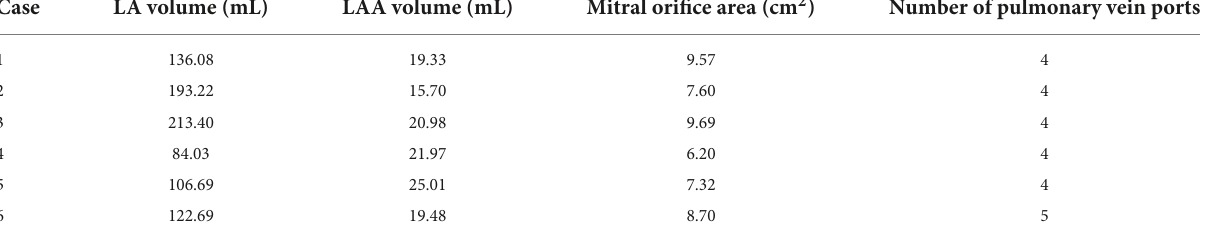
FIGURE1 LA 3D models of six patients with AF.